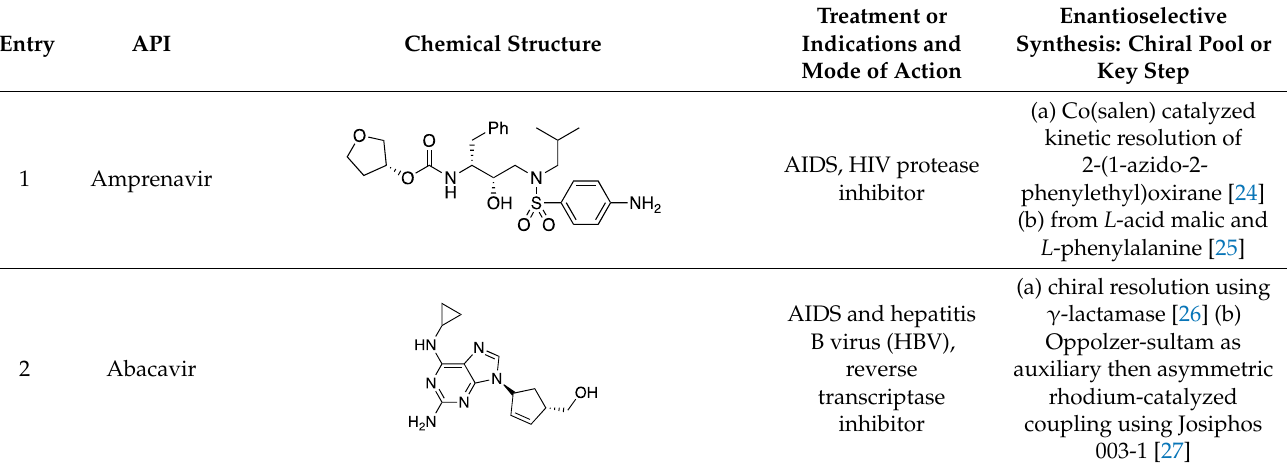
Table 1. Selected chiral antiviral drugs.